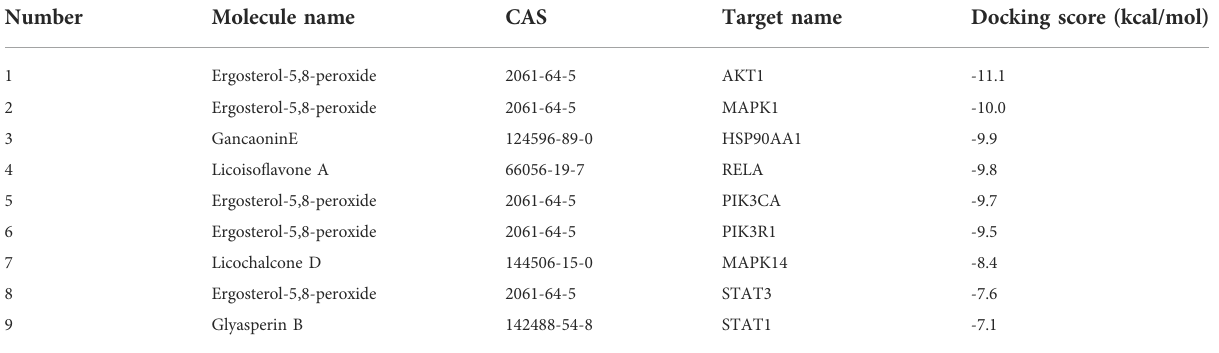
TABLE 4 Molecular docking